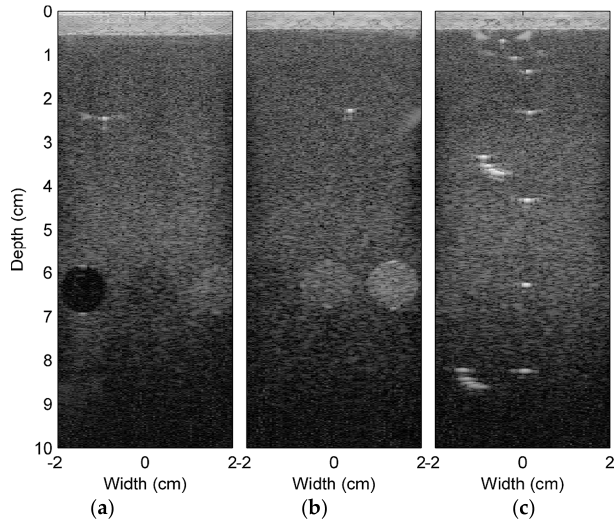
Figure 5. Ultrasound image references scanned at different locations of the precision multi-purpose phantom that are used in Experiments 1–3 ( a – c ), respectively.